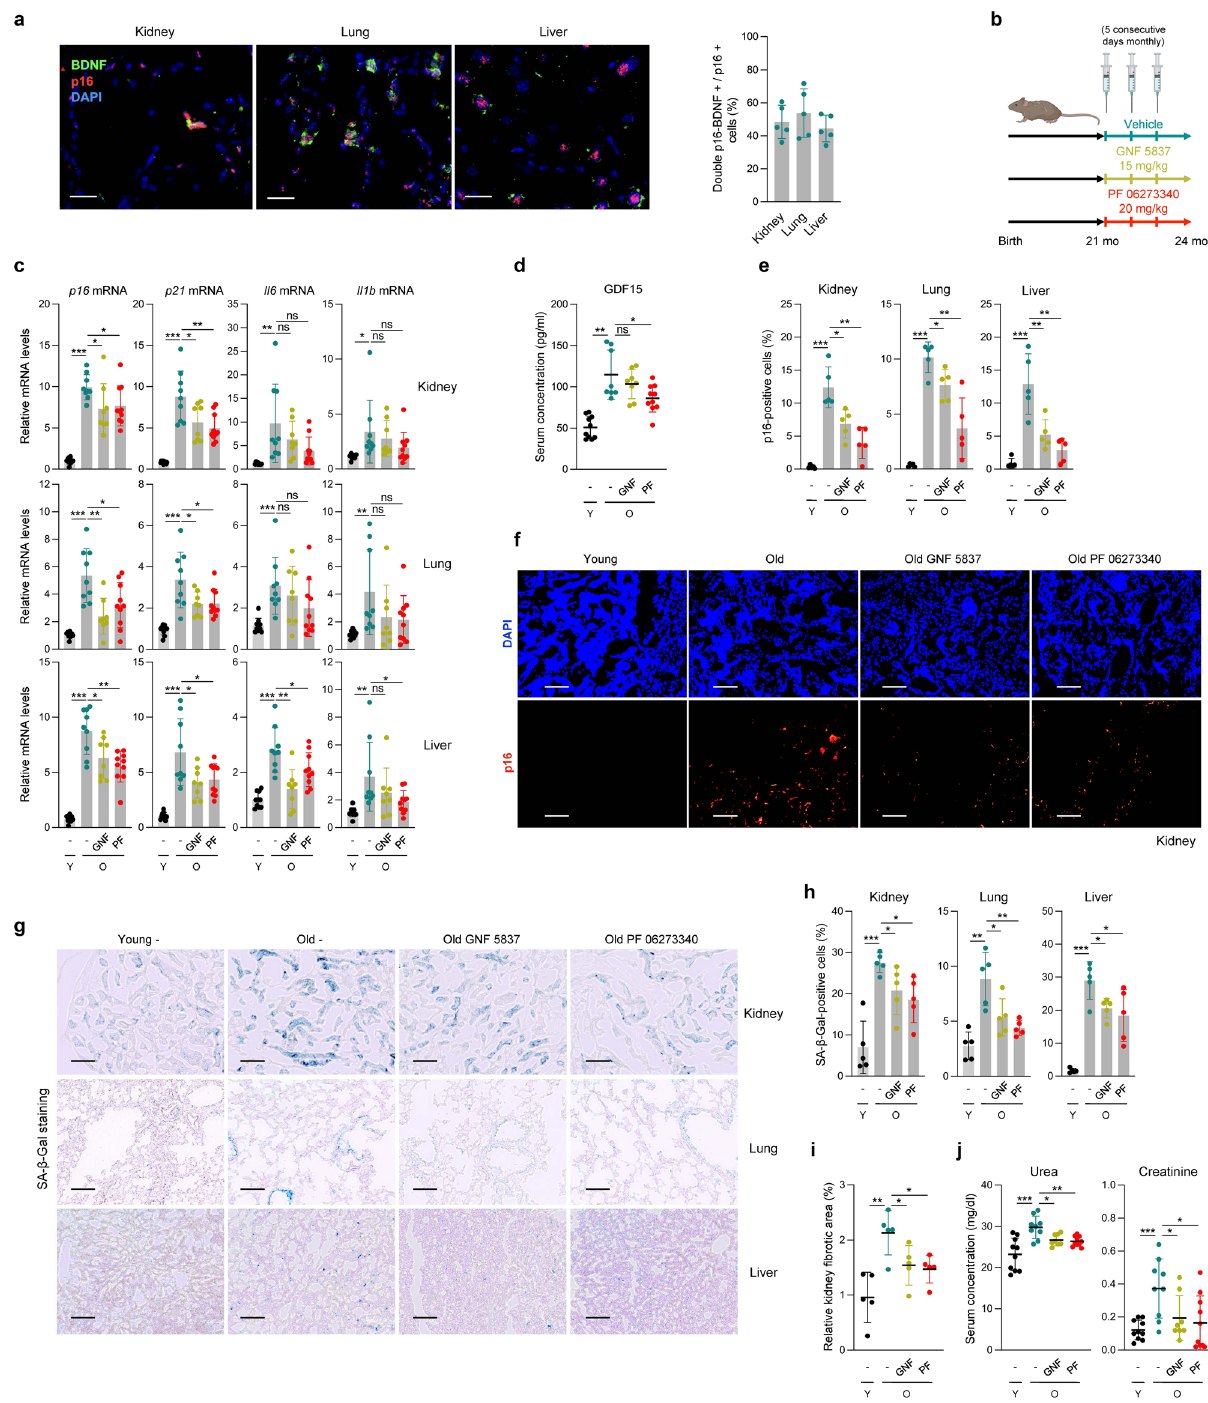
Fig. 7 | Treatment withTrkB inhibitors reduces senescent cells in organs from oldmice.a Immuno fl uorescencestainingofBDNF(green)andp16(red)inkidney, lung, and liver from 24-month old (m.o.) C57BL/6J mice. Scale bars, 20 µ m. The percentages of double p16- and BDNF-positive cells among the total p16-positive cells were analyzed ( n =5 mice, 24m.o.) and plotted ( right ). b Schedule of administration of TrkB inhibitors GNF 5837 and PF 06273340 to normally aging mice.GroupsincludedareY(young,3m.o.)andO(old,24m.o.);-(untreated),GNF (GNF5837),andPF(PF06273340).CreatedusingBioRender. c RT-qPCRanalysisof the abundance of p16 , p21 , Il6 , and Il1b mRNAs in kidney, lung, and liver in the different mouse cohorts. d GDF15 concentration in sera from the four mouse cohorts, as measured with a Bioplex instrument. Percentages of p16-positive cells